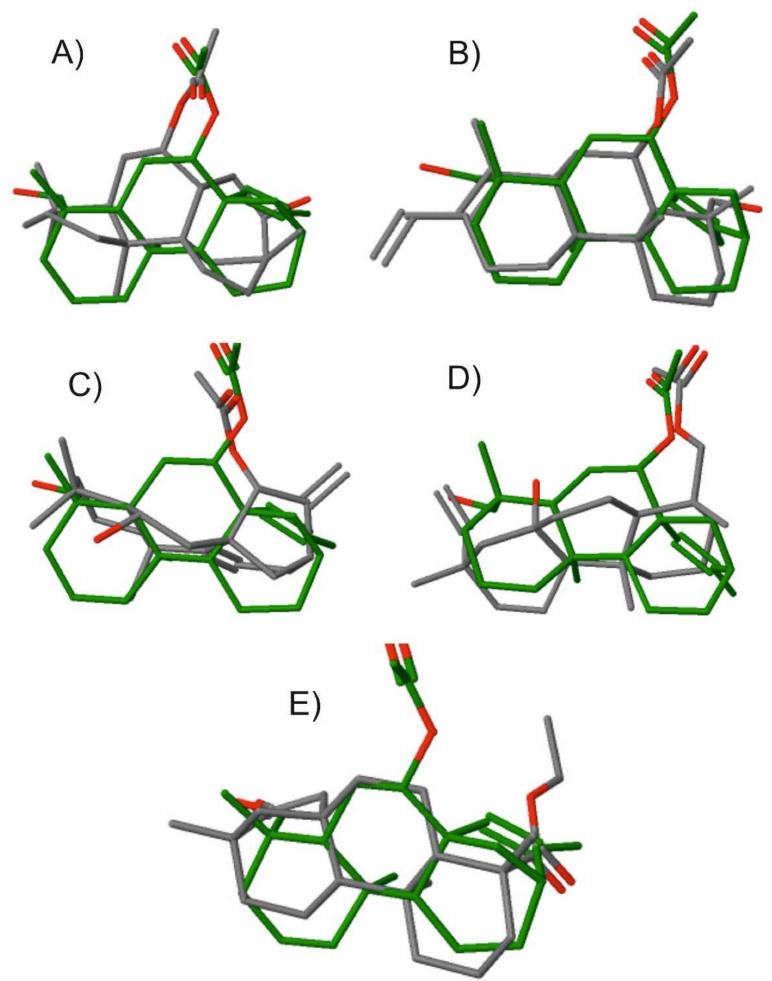
Figure 5. Superposition of siderol (colored in green) with di ff erent identified bioactive compound hits (colored in grey). ( A ) (4a S ,6 S ,6a S ,8 S ,9 R ,11a S ,11b S